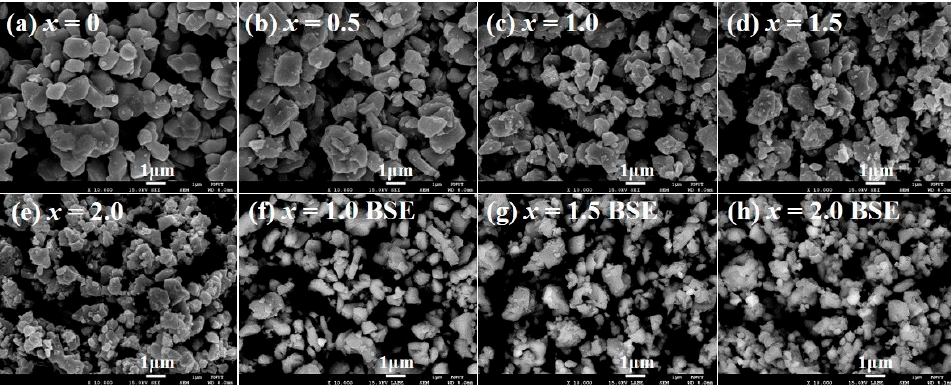
Figure 4. ( a – e ) SEM micrographs of SrFe 12 − 2x Zn x Zr x O 19 ( x = 0, 0.5, 1.0, 1.5, 2.0) powder samples calcined at 1250 °C. ( f – h ) BSE images of SrFe 12 − 2x Zn x Zr x O 19 with x = 1.0, 1.5, and 2.0 calcined at 1250 °C.